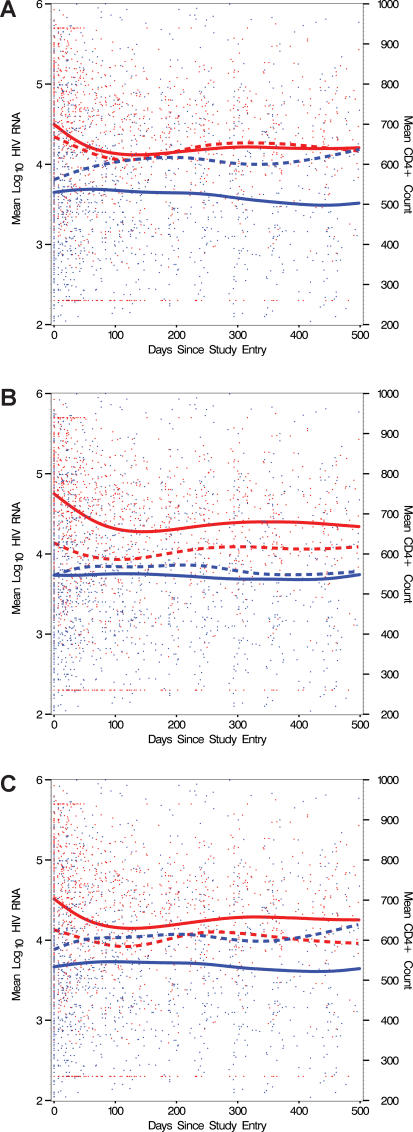
Effects of Bw4Ile80 and KIR3DS1 Gene Carriage on HIV Disease Outcome(A) Those with KIR3DS1 (dashed line) versus those without KIR3DS1. The dashed red line represents a moving average of HIV-1 RNA levels over time among those carrying at least one KIR3DS1 allele. The solid red line represents those that do not carry the KIR3DS1 allele. The dashed blue line represents a moving average of CD4+ T cell counts over time among those carrying at least one KIR3DS1 allele. The solid blue line represents those that do not carry the KIR3DS1 allele.(B) Those with Bw4Ile80 (dashed line) versus those without Bw4Ile80. The dashed red line represents a moving average of HIV-1 RNA levels over time among those carrying at least one Bw4Ile80 allele. The solid red line represents those that do not carry the Bw4Ile80 allele. The dashed blue line represents a moving average of CD4+ T cell counts over time among those carrying at least one Bw4Ile80 allele. The solid blue line represents those that do not carry the Bw4Ile80 allele.(C) Those with both the Bw4Ile80 and KIR3DS1 alleles (dashed line) versus those without both alleles. The dashed red line represents a moving average of HIV-1 RNA levels over time among those carrying both the Bw4Ile80 and KIR3DS1 alleles. The solid red line represents those that do not carry both the Bw4Ile80 and KIR3DS1 alleles. The dashed blue line represents a moving average of CD4+ T cell counts over time among those carrying at both the Bw4Ile80 and KIR3DS1 alleles. The solid blue line represents those that do not carry both the Bw4Ile80 and KIR3DS1 alleles.